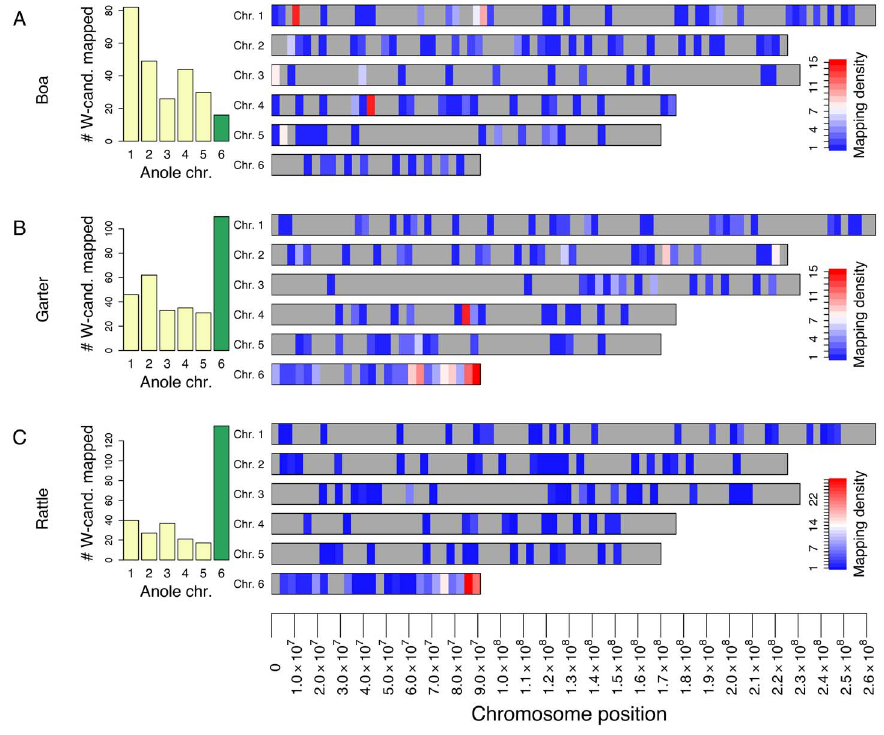
Figure 2. Mapping of the best candidate female-specific W-candidate scaffolds of (A) boa, (B) garter snake, and (C) pygmy rattlesnake to the Anolis macrochromosomes. The histograms (left) show the number of candidate W scaffolds mapped to the six major chromosomes of Anolis , with the green bar highlighting the Anolis homolog to the snake Z chromosome. The W candidates homologous to Z-linked scaffolds (which accounts for 7.6% of the genome) make up 49% and 35% of all female-biased scaffolds in pygmy rattlesnake and garter snake, respectively. This is a 6.4-fold excess in pygmy rattlesnake, and 4.5-fold excess in garter snake over random mapping based on chromosome size. In contrast, in Boa, only 6.5% of scaffolds map to chromosome 6, which does not differ from random mapping on the basis of chromosome size. The right panel shows color-coded mapping density of W-candidates along the Anolis macrochromosomes. The density of W-candidates is not uniform across the Z chromosome in both pygmy rattlesnake and garter snake ( p , 0.0001 for mean nearest neighbor distances). The data in this figure are from all female biased candidate W-linked scaffolds and will thus contain both non-coding scaffolds as well as scaffolds containing protein coding genes.